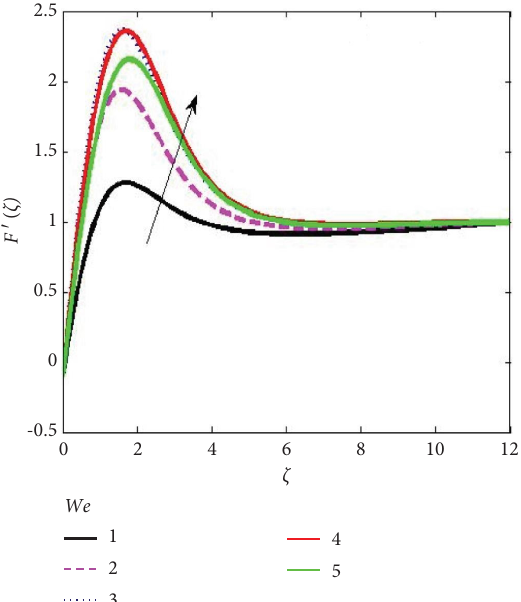
Figure 3: Efect of Deborah number on the velocity distribution.